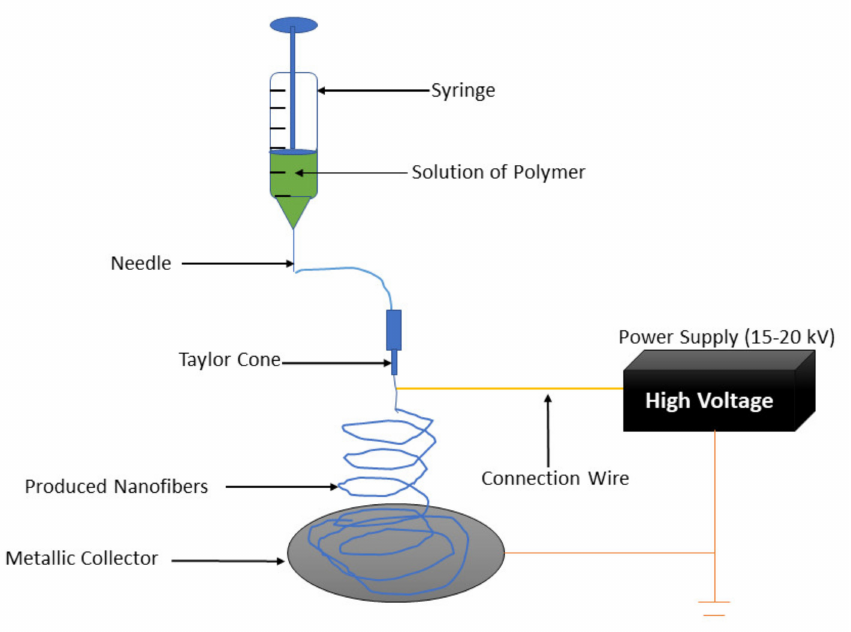
Figure 4. Electrospinning